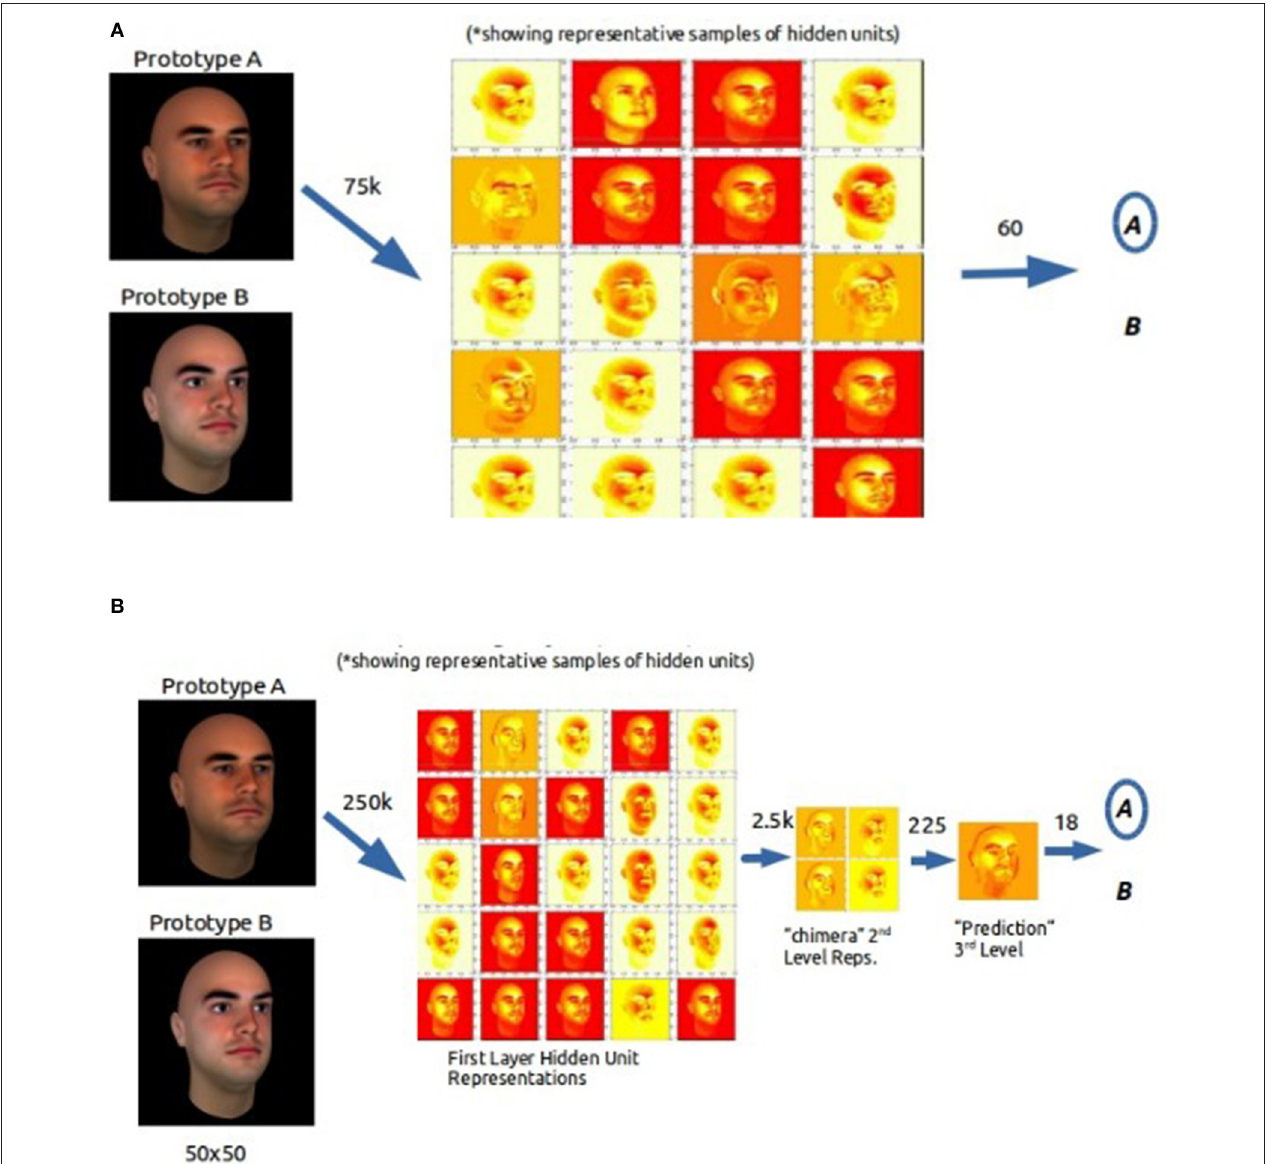
FIGURE 7 | Visualizations of the internal representations of a representative sample of the hidden units in the BP (A) and the DL (B) learning categories in the FS